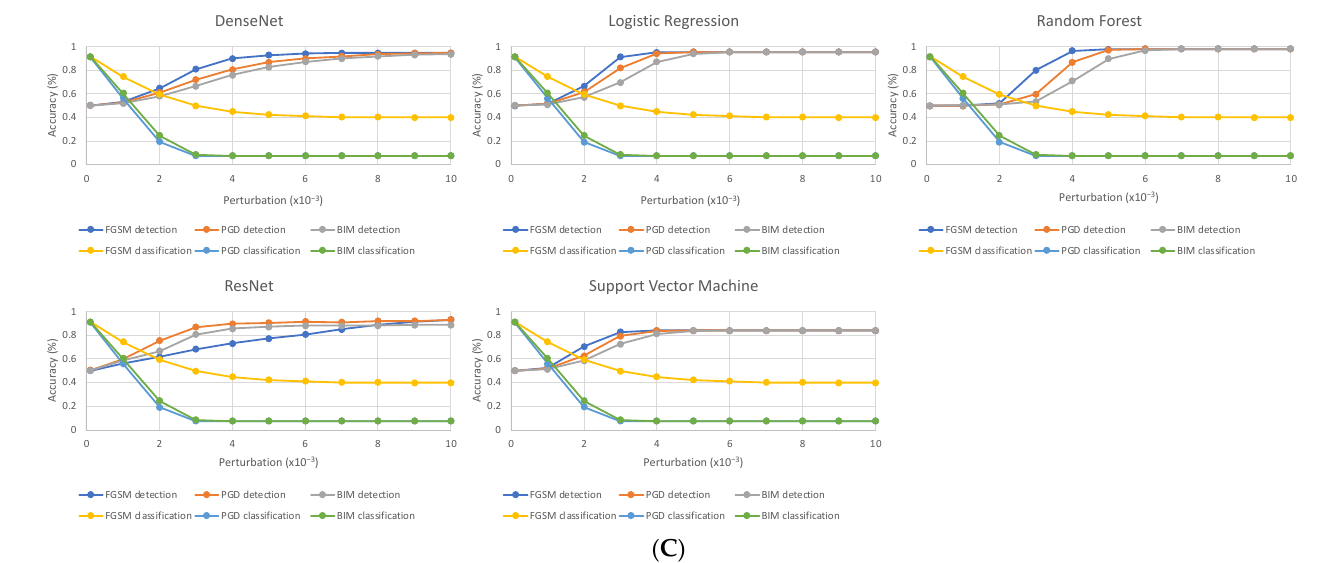
Figure 2. Detection accuracy (%) of detector models (DenseNet, Logistic Regression, Random Forest, ResNet, and Support Vector Machine) on the combination of normal and adversarial test samples along with classification accuracy (%) of VGG16 classification model on adversarial samples as L ∞ maximum perturbation size ε is increased. As ε was increased, detection accuracy increased while classification model accuracy decreased for all datasets and attack types. Results are shown for ( A ) lung CT, ( B ) mammogram, and ( C ) MRI. Detection accuracy is measured as the percentage of images in the combined test set correctly classified by detection model to be normal or adversarial, while classification accuracy is measured as the percentage of images in the normal test set correctly classified by the VGG16 classification model as malignancy or no malignancy. Table 1. Accuracy score (%) of DenseNet, Logistic Regression, Random Forest, ResNet, and Support Vector Machine detector models on a combination of normal samples and adversarial samples crafted by designated attack (FGSM, PGD, or BIM) at a set L ∞ maximum perturbation of 0.004 or 0.008 for lung CT, mammogram, and brain MRI datasets.